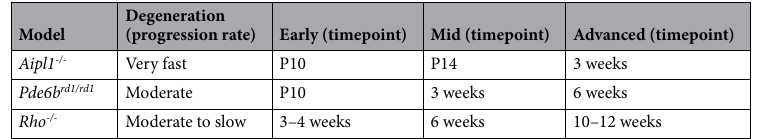
Table 1. Summary of timepoints used in retinal degeneration